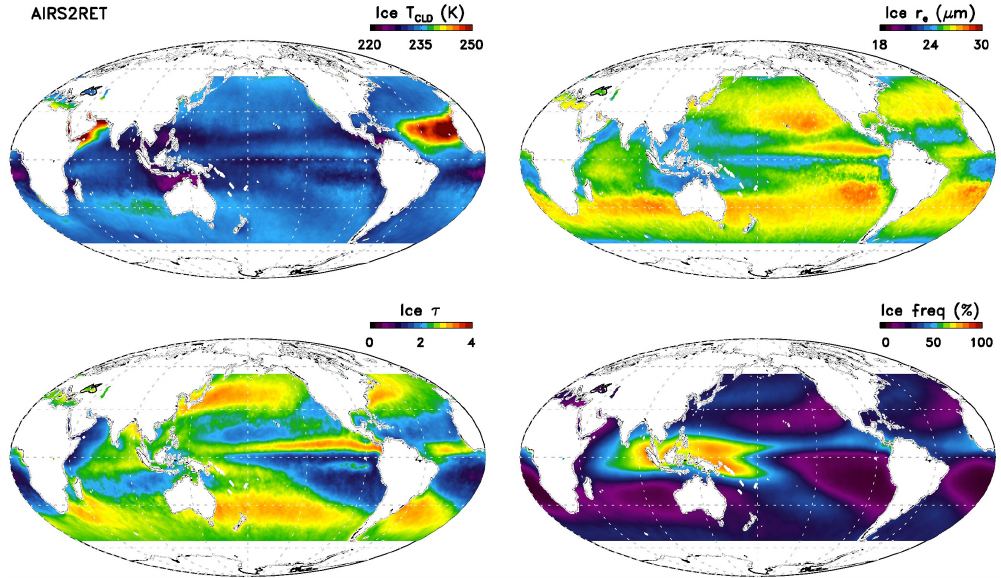
Figure 1. The global 14-year averages (1 September 2002–31 August 2016) of T ci , r ei , τ i , and ice cloud frequency, for the AIRS IR only retrieval (AIRS2RET) between 54 ◦ S and 54 ◦ N over the oceans. Note that the maximum T ci value is higher than indicated in the colour bar.